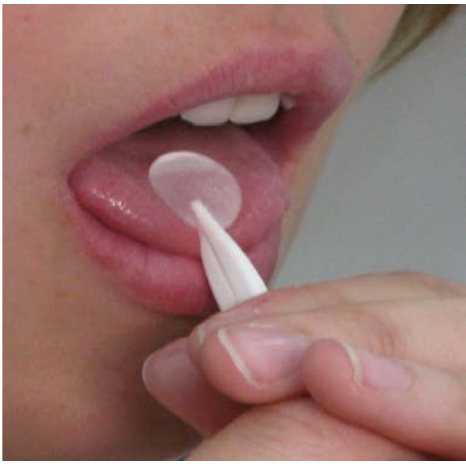
Figure 1. Photograph showing a stimulus presentation in the fatty acid flavor threshold assessment. The stimulation was performed by positioning, on the anterior part of the tongue, the paper disk impregnated with 10 μL of a mixture of oleic acid (or triolein) and mineral oil with the former ranging from 0.0015 to 10 μL